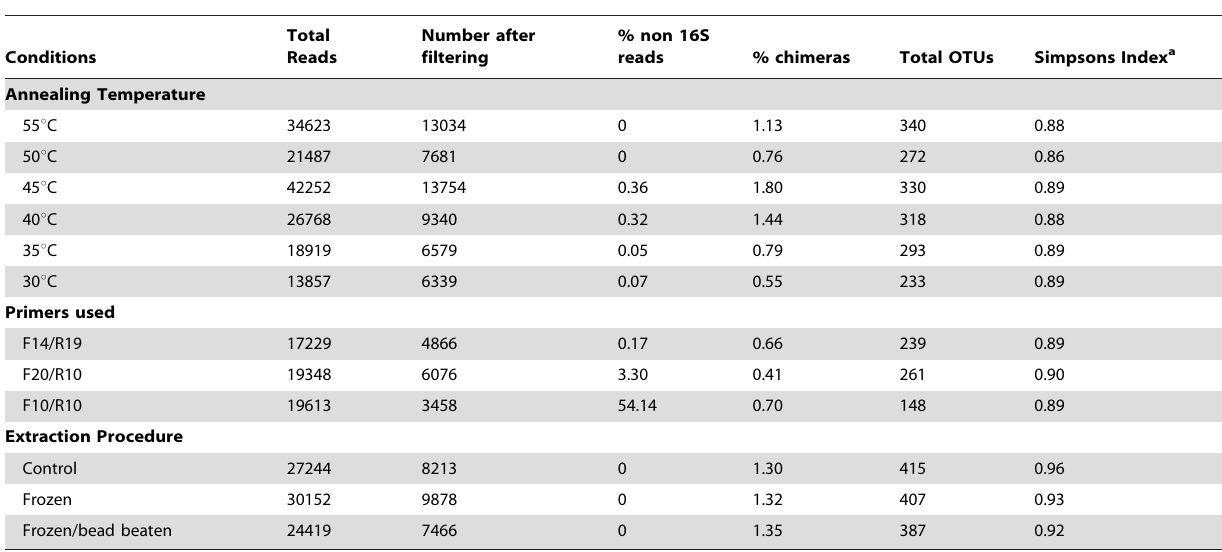
Table 1. Summary of the reads obtained under different experimental